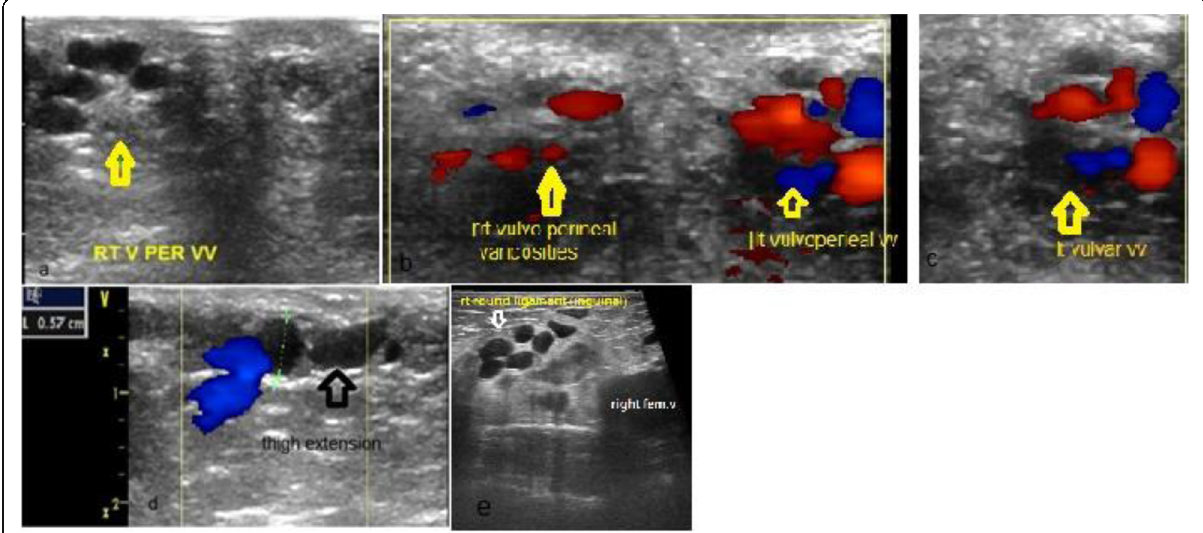
Fig. 3 a – e trans-perineal and inguinal ultrasound and color Doppler images showing vulvoperineal and round ligament (inguinal) varicosities being right sided in ( a ) (open yellow arrow) bilateral in ( b ) (open yellow arrows) and left sided in ( c ) (open yellow arrow). Extension of the vulvoperineal varicosities into the relevant proximal thigh was seen in ( d ) (black open arrow) with a vein diameter=5.7mm. ( e ) demonstrating right inguinal (round ligament) varicosities that were detected at the level of the external ring (open white arrow) just above the femoral vein (right fem.